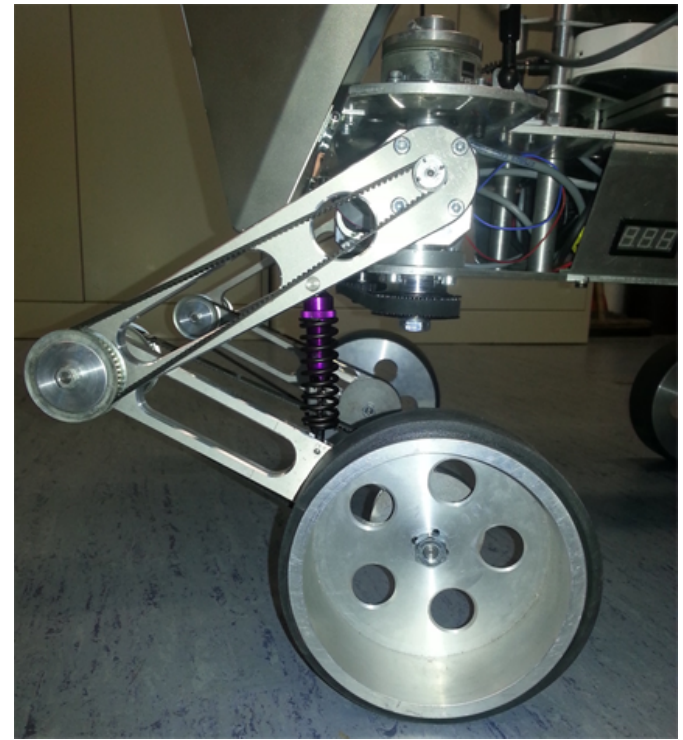
Figure 3. Suspension